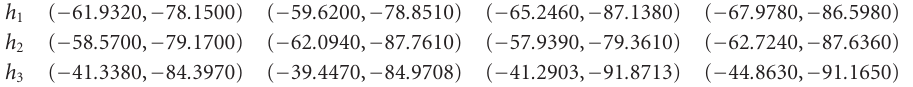
Figure 4.5 is the image of the quadrangle (cid:2) D and its image under the fourth